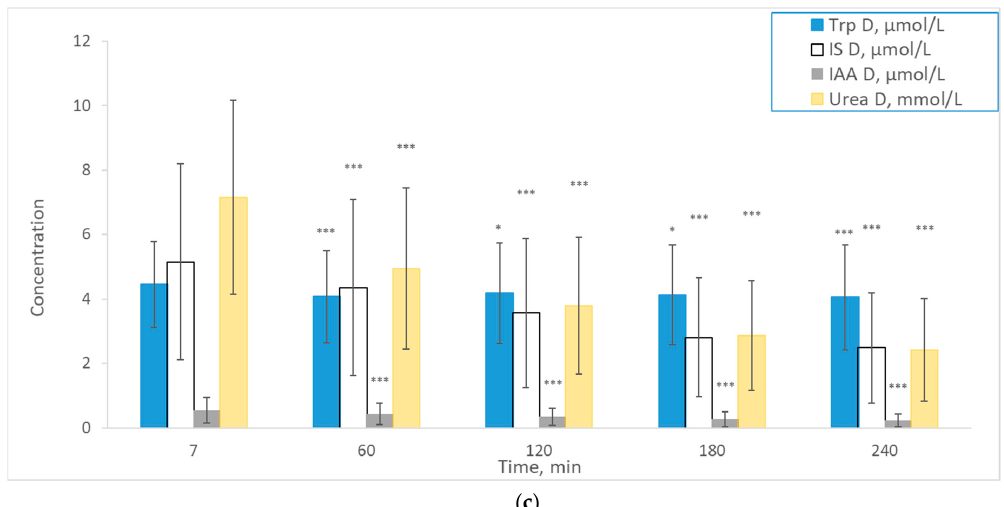
Figure 1. Mean ± SD concentrations at different time points during the dialysis sessions for Trp, IS, IAA (µmol/L) and urea (mmol/L) for ( a ) total serum values ( n = 310); ( b ) free serum values ( n = 310); and ( c ) dialysate values ( n = 257). *** p < 0.001; ** p < 0.01; * p < 0.05 vs. previous timepoint value.